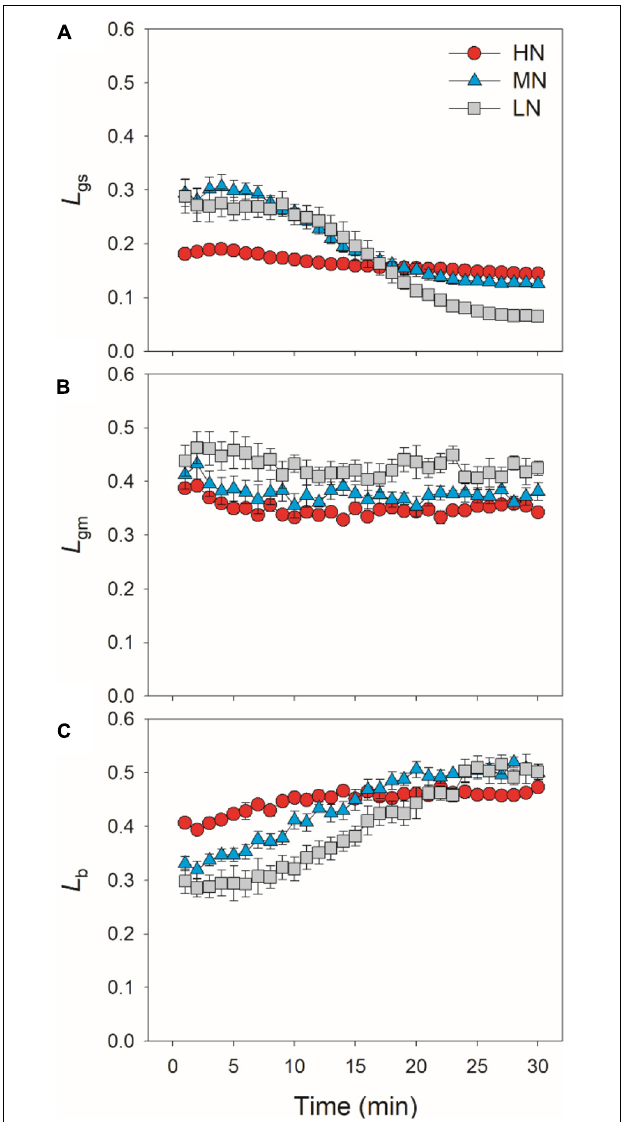
FIGURE 6 | Quantitative analysis of the relative limitations of g s (A) , g m (B) and biochemical factors (C) imposed to photosynthesis after transition from 50 to 1,500 µ mol photons m − 2 s − 1 . Values are means ± SE ( n = 5). HN, MN, and LN represent tomato plants grown under high, medium, and low N concentrations, respectively.